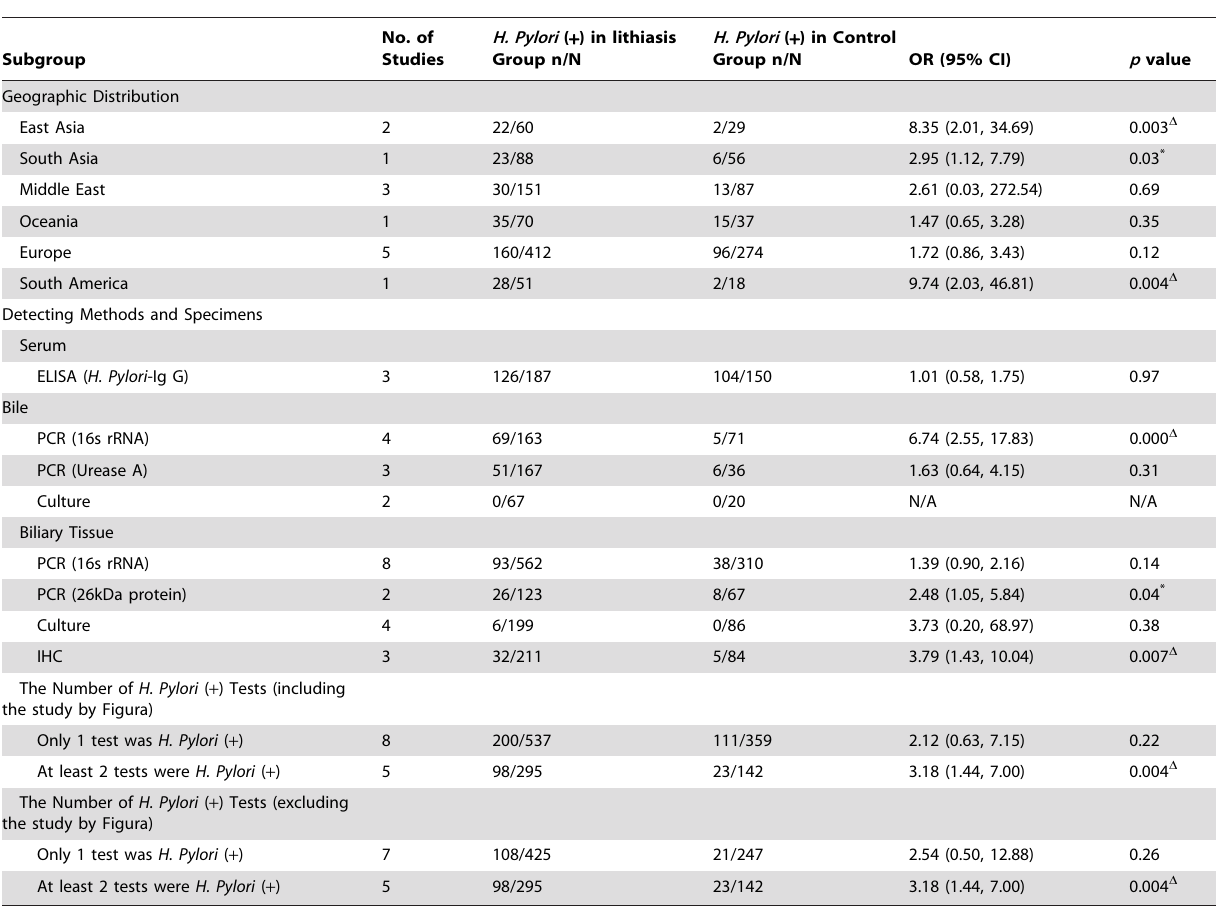
ELISA: enzyme-linked immunosorbent assay; PCR: polymerase chain reaction; RNA: ribonucleic acid; Urea A: Urease A; IHC: immunohistochemistry; OR, odds ratio; CI, confidence interval; D : p , 0.01; *: p ,